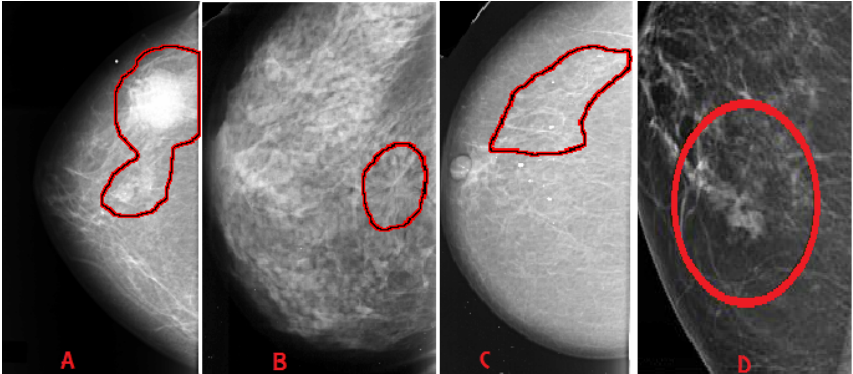
Figure 3. Categories of breast abnormalities. ( A ) Mass—well-defined irregular lesion, suspicious spicu- lated mass. ( B ) Architectural distortion. ( C ) Calcification—discrete microcalcification. ( D )